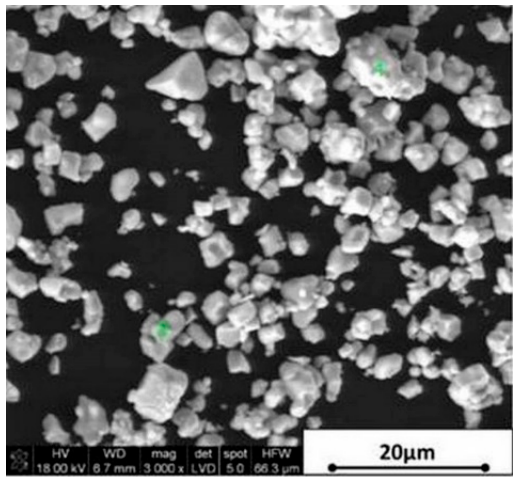
Figure 1. Morphology of PZT commercial powder used for the production of particulate piezoelectric composite.